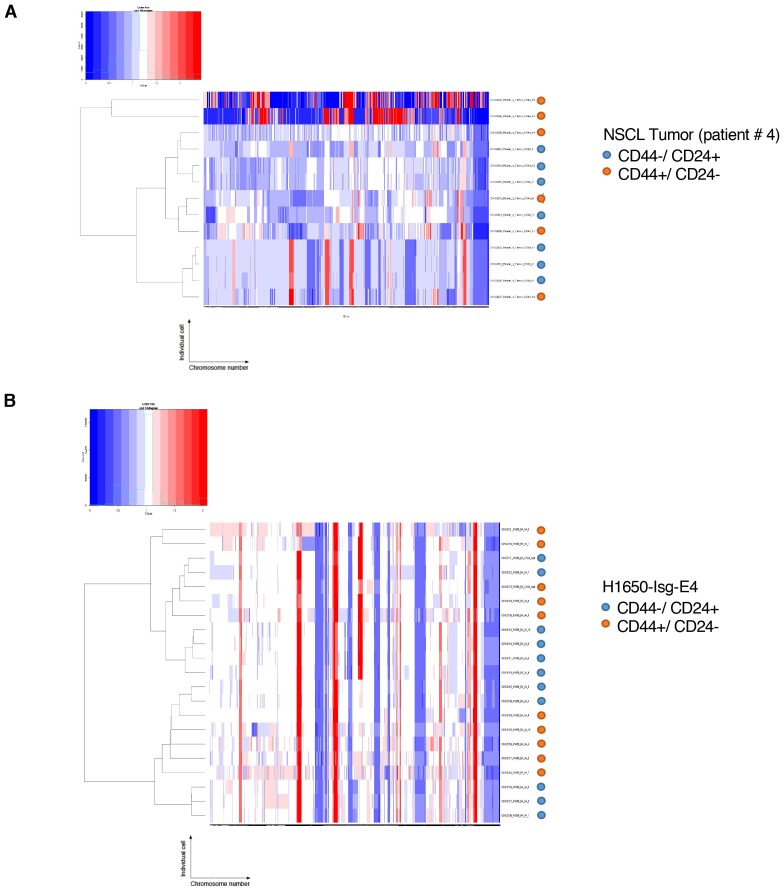
Heat-map of normalized read counts of FACS-sorted cells based on CD44 and CD24 surface markers from patient tumor and from the H1650-derived isogenic cell line H1650-Isg-E4.Heat-maps of normalized read counts across segment breakpoints (using Euclidian distance and ward clustering method) of CD44+/CD24− cells and CD44−/CD24+ cells sorted from (A) an NSCL tumor (patient #4) and (B) the H1650-derived isogenic cell line (H1650-isg-E4) are displayed. CD44−/ CD24+ cells are marked with a blue circle and CD44+/CD24− cells are marked with an orange circle. The cluster dendogram and heat-map of normalized read counts were generated using Ginkgo, an open-source web platform for interactive analyses of CNA (Garvin et al., 2015) (http://qb.cshl.edu/ginkgo).